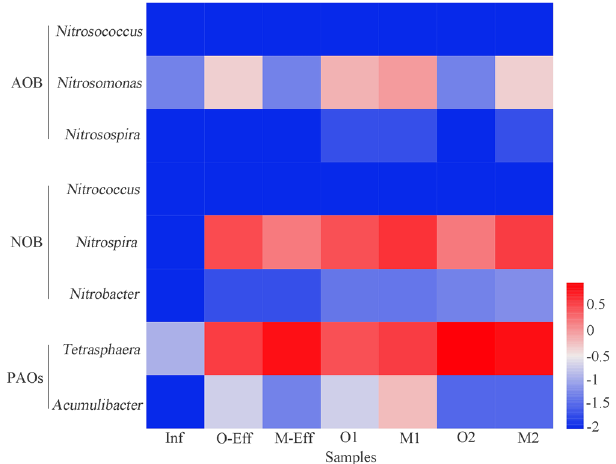
Figure 3. AOB, NOB, and PAOs distribution in all samples.